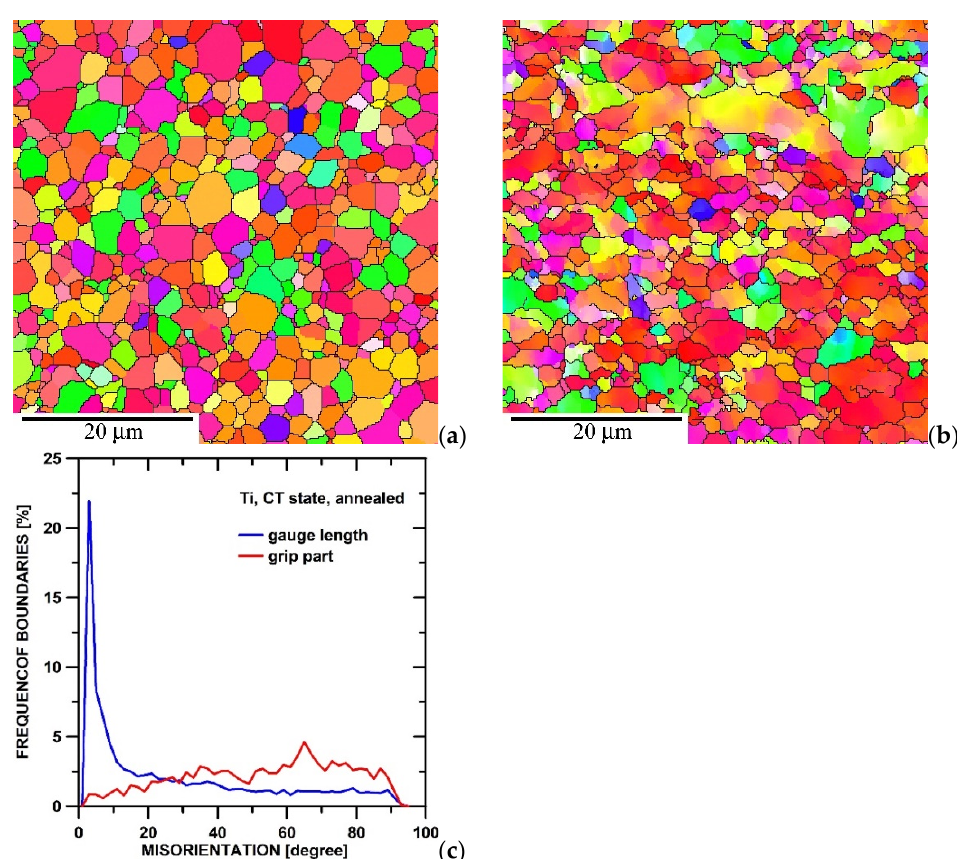
Figure 7. Microstructure of annealed CT state after creep testing at 200 MPa and 673 K: ( a ) grip part, ( b ) gauge length, and ( c ) misorientation distributions.